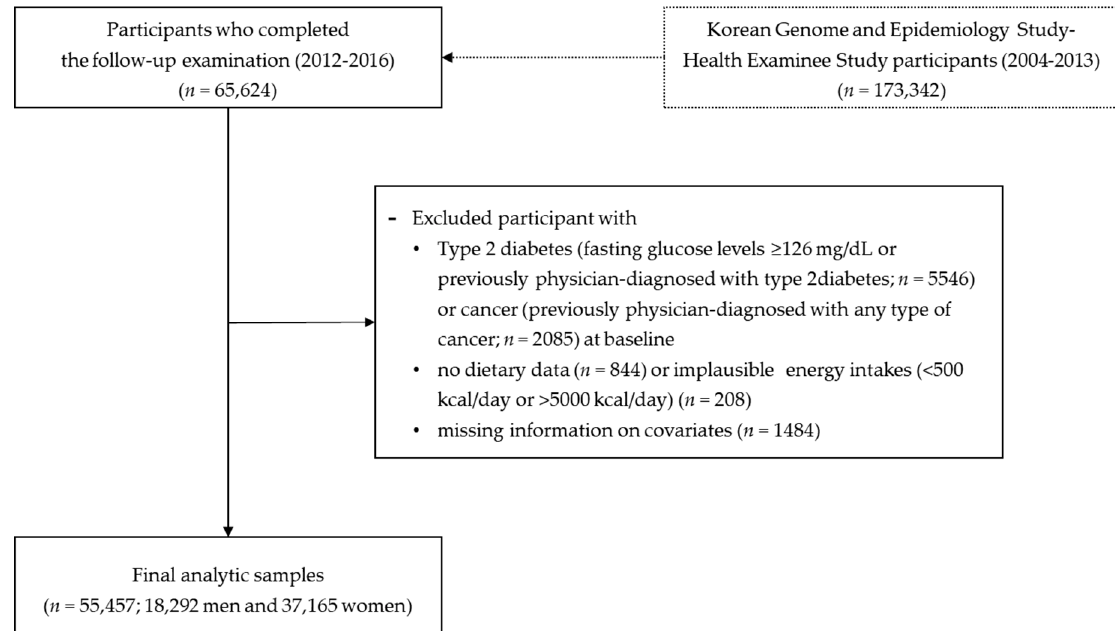
Figure 1. Flowchart of study population selection.